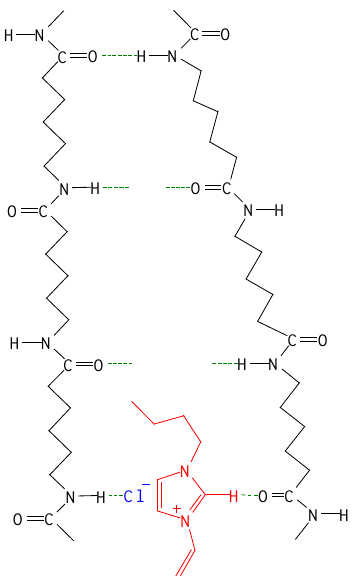
Figure 12. Schematic diagram of destruction and re-building of the hydrogen bond with the incorporation of excess VBIM.